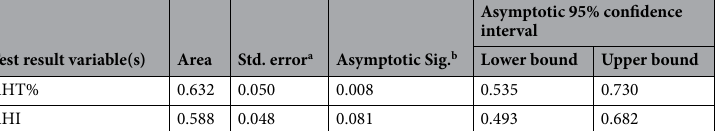
Table 2. Comparison of ROC curves of AHT% and AHI for predicting ESS ≥ 11. The test result variable(s): AHI has at least one tie between the positive actual state group and the negative actual state group. Statistics may be biased. Columns indicate metrics of regression performance, including the coefficient. Plots from the ROC analysis are shown in Fig. 2. a Under the nonparametric assumption. b Null hypothesis: true area = 0.5.